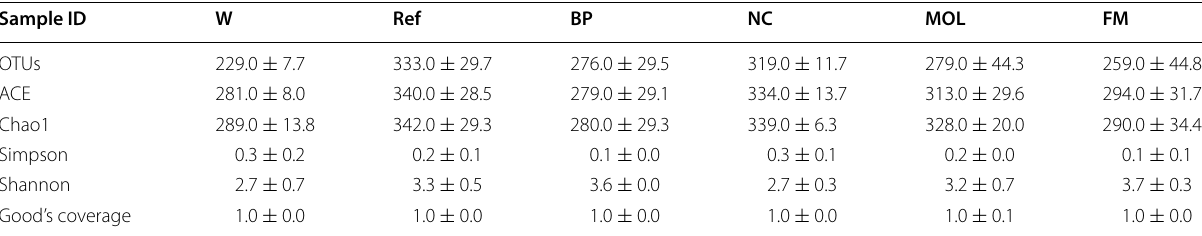
Table 4 OTUs, ACE, Chao 1, Simpson, Shannon and Good’s coverage for 16s rRNA libraries of all samples